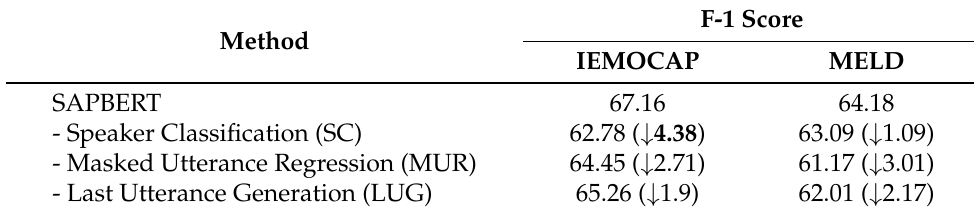
Table 6. Results of ablation study on IEMOCAP and